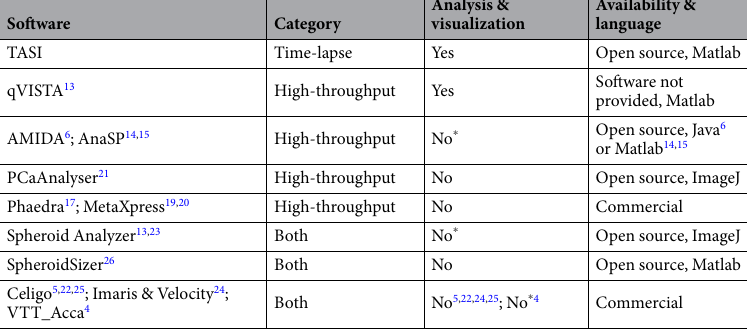
Table 1. Summary of software available for spheroid image analysis. * Requires other statistical/visualization software, such as R, Excel or additional Matlab